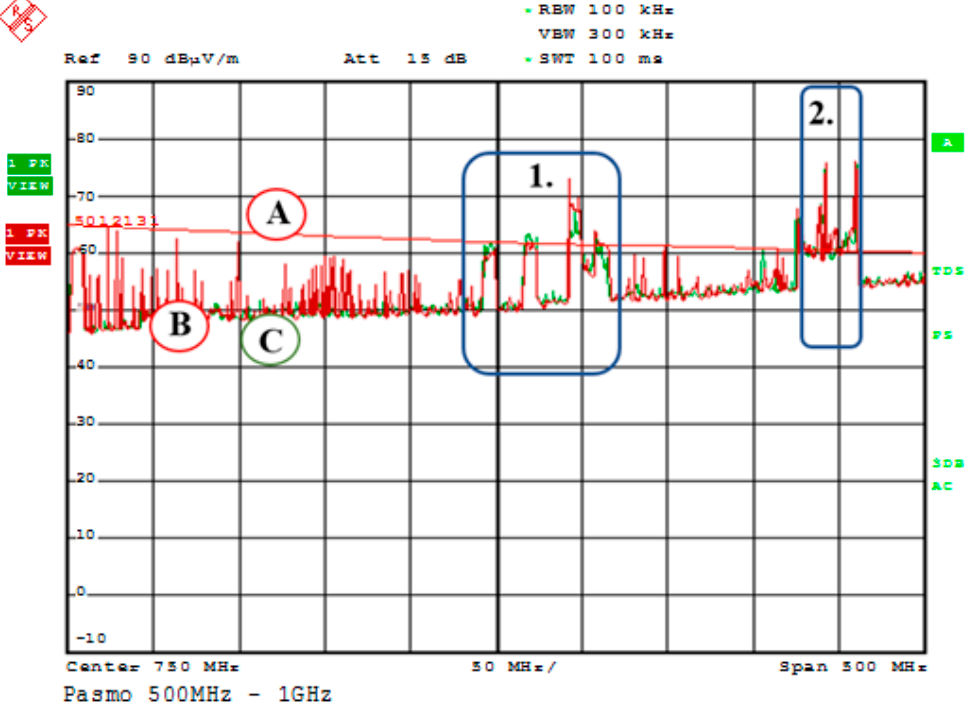
Figure 14. Spectrum of interfering signals radiated by a rail vehicle travelling at a speed of 50 km/h and the electromagnetic background for a frequency range of 500 MHz–1 GHz.